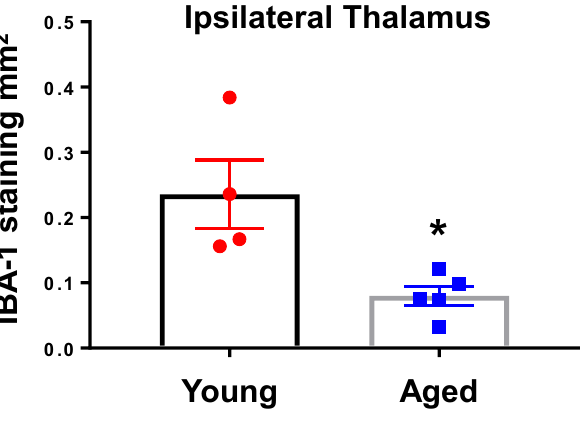
Figure 5. Aged mice demonstrate reduced IBA-1 expression in ipsilateral thalamus at PSD 14 compared with young mice. ( A ) Representative images comparing IBA-1expression in brain of young (11–13 weeks) and aged (19–21 months) mice at PSD 14. Imaged with 10X obj, stitched image; scale bar = 1 mm (left panel) or 250 µm (middle panel). Blow up imaged with 40X obj; scale bar = 20 µm (right panel). ( B ) Quantification of total IBA-1 stained area in ipsilateral thalamus of young and aged mice. * P < 0.05, unpaired t